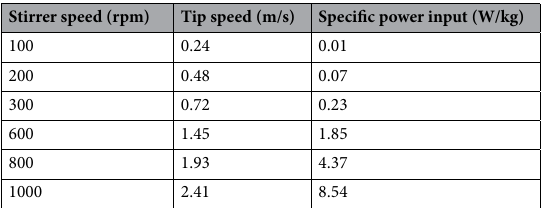
Table 1. Stirrer speeds with corresponding tip speeds and calculated specific power input.